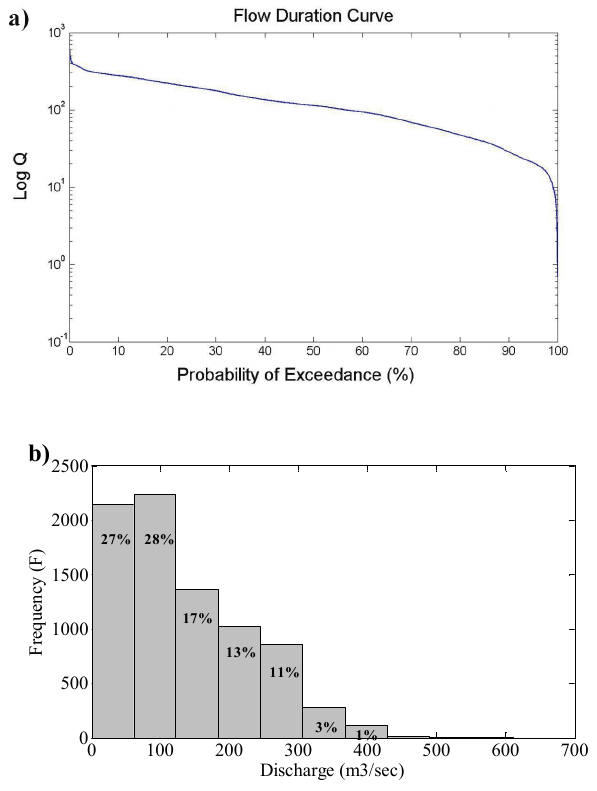
Fig. 3. Observed daily discharge (m 3 sec − 1 ) for 1985–2006 for Nzoia River (a) Flow duration curve (b) histogram.